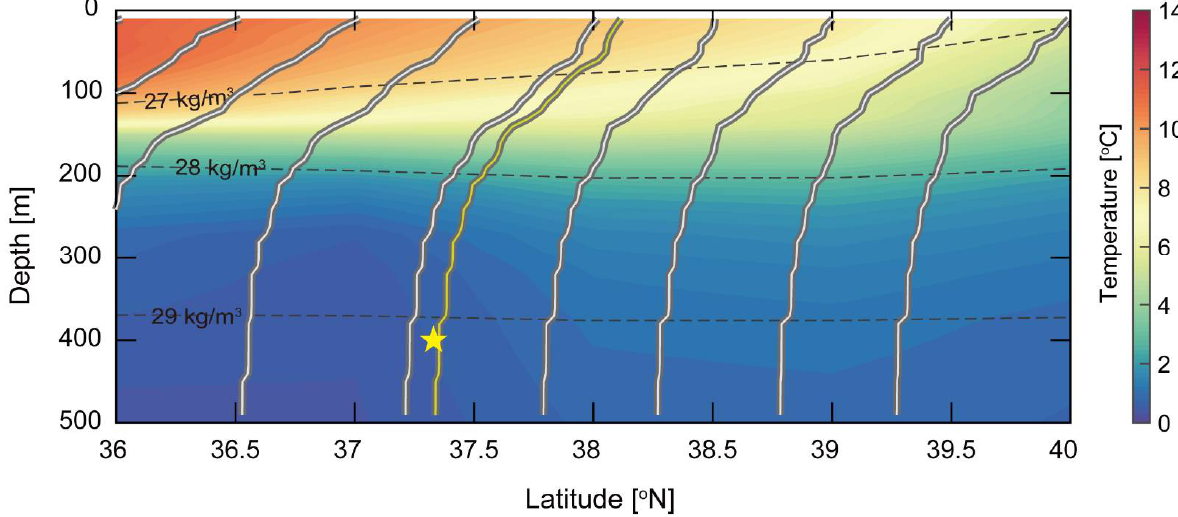
Figure 10. Ray path of near-inertial internal waves (NIWs) (thick, white, solid line) in the spatially varying stratification observed in March 2018 (H8). Yellow solid line indicates ray path that could reach the depth of 400 m at EC1 (yellow star). Background colour indicates potential temperature, and dashed line indicates isopycnals of 27, 28, and 29 kg/m 3 .